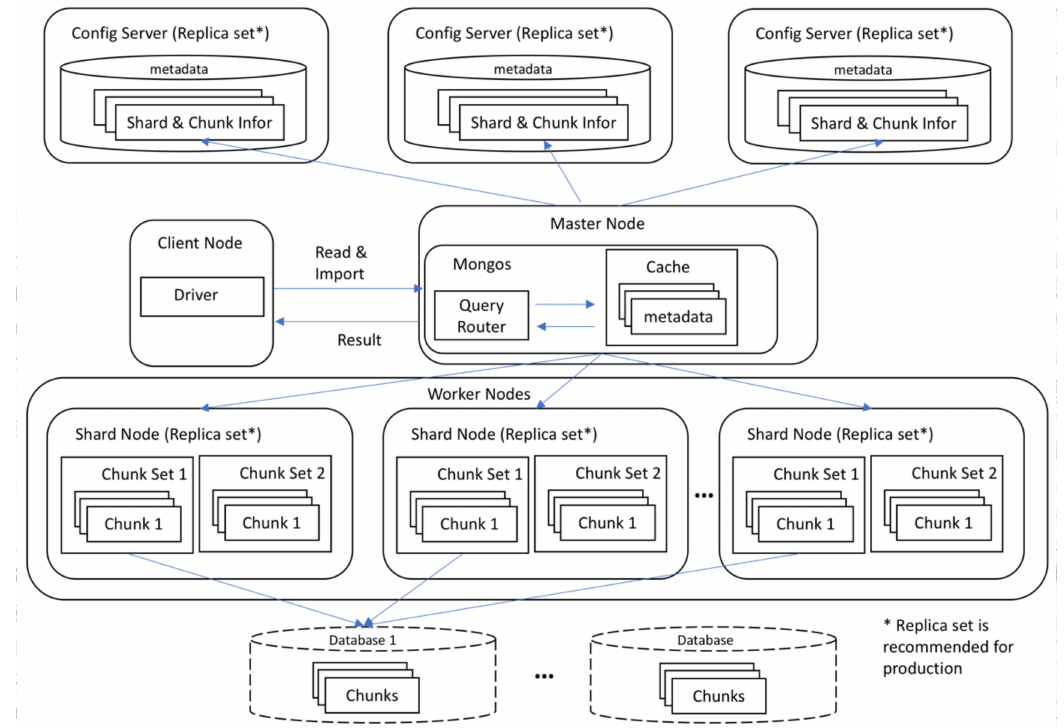
Figure 6. The architecture of MongoDB.